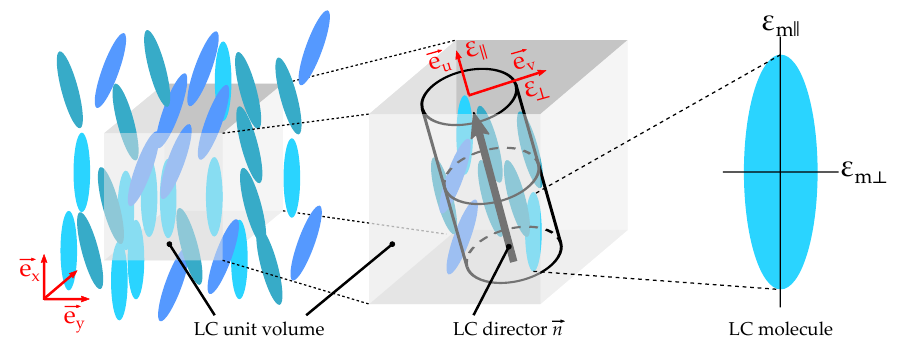
Figure 3. Definition of the director ~ n for a single LC unit volume element in the device’s coordinate system ( xyz ) and relation to the permittivities defined in the material’s coordinate system ( uvw ) with the material properties ε m , ε m and the macroscopic unit volume properties ε ⊥ k ⊥ (cid:107)